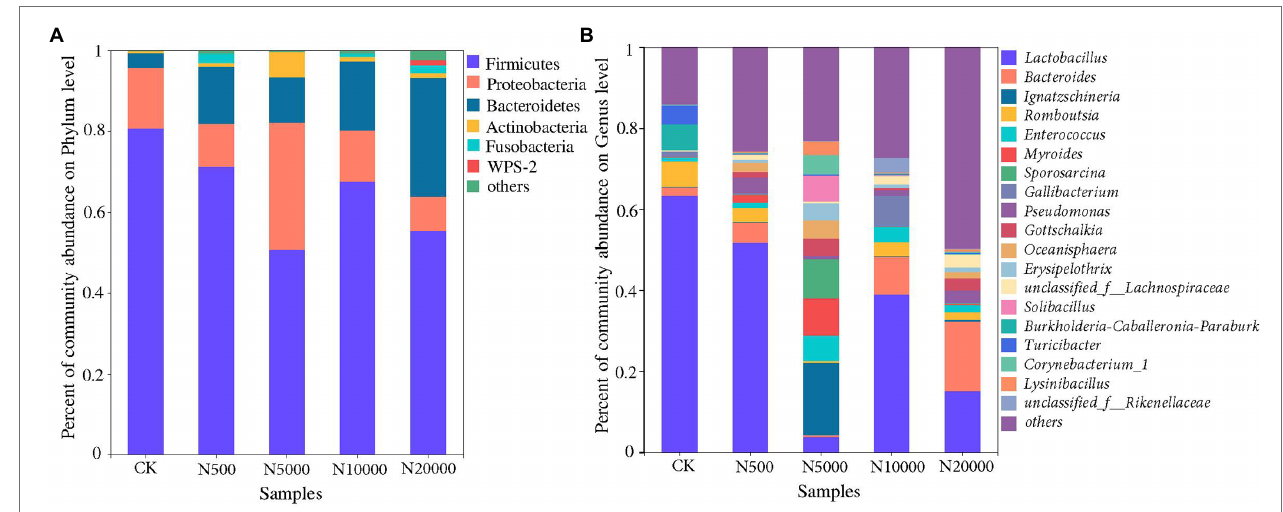
FIGURE 4 | The bacterial community composition at the phylum level (A) and genus level (B) in different layer manure